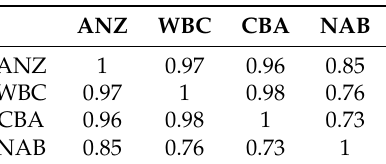
Table 3. Price correlation coefficients of the four largest banks.